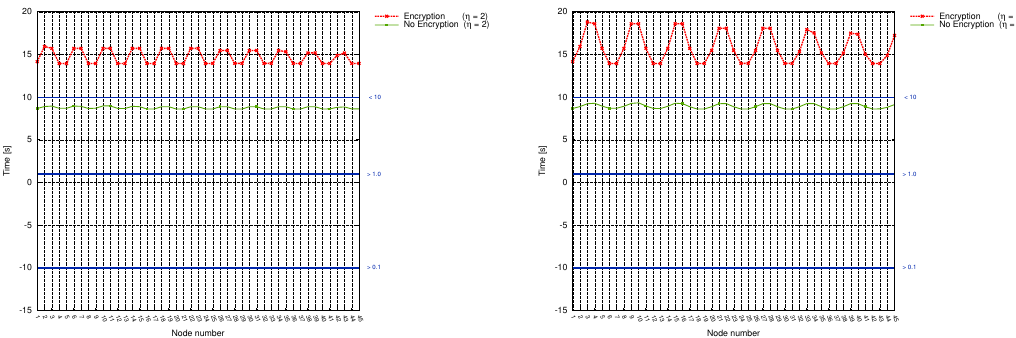
Figure 9. Scenarioss 3a,b, 4a,b: correlation between the sink number, time and power grid disturbance time frames (encryption/no encryption).